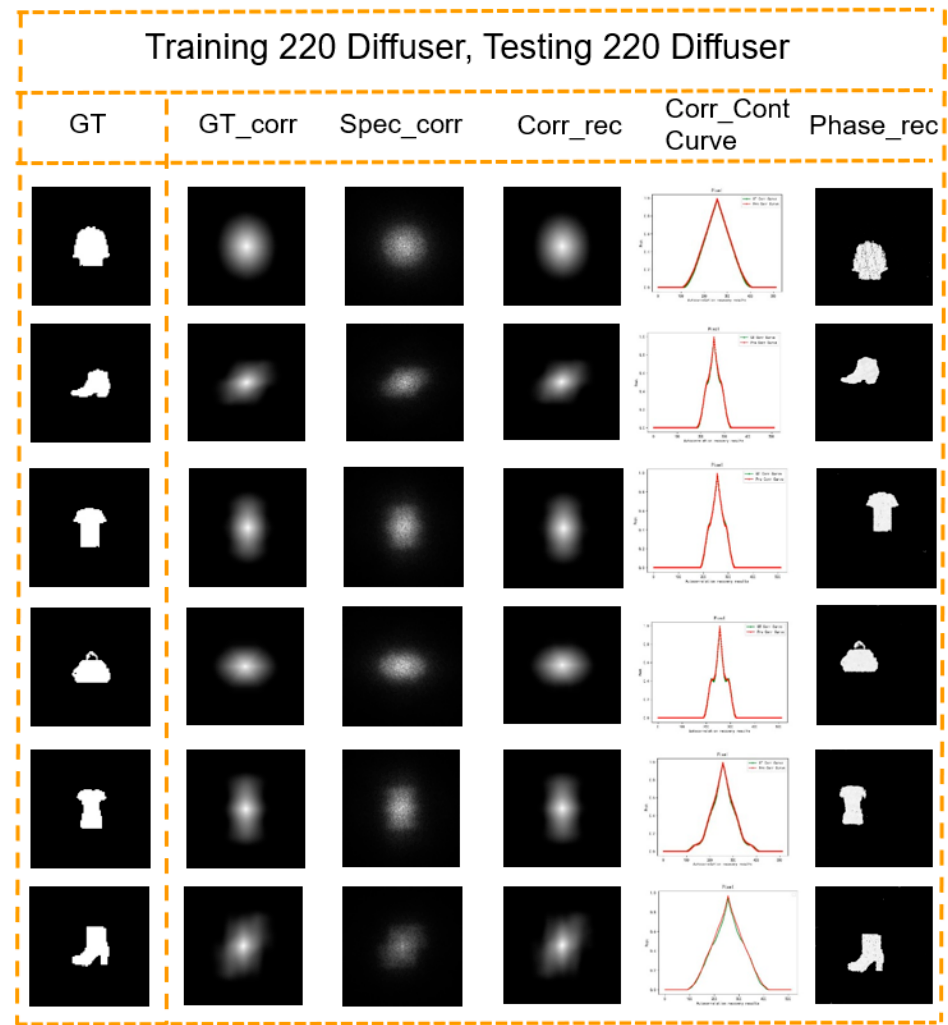
Figure 9. Test results under 220-mesh frosted glass. GT is the truth value of the target, GT_corr represents the truth value autocorrelation, Spec_corr is the speckle autocorrelation under 220-mesh frosted glass, Corr_rec is the depth model prediction result, Corr_Cont Curve is the comparison value between the depth model prediction result and the truth value autocorrelation result, and Phase_rec represents the phase-recovery reconstruction result.